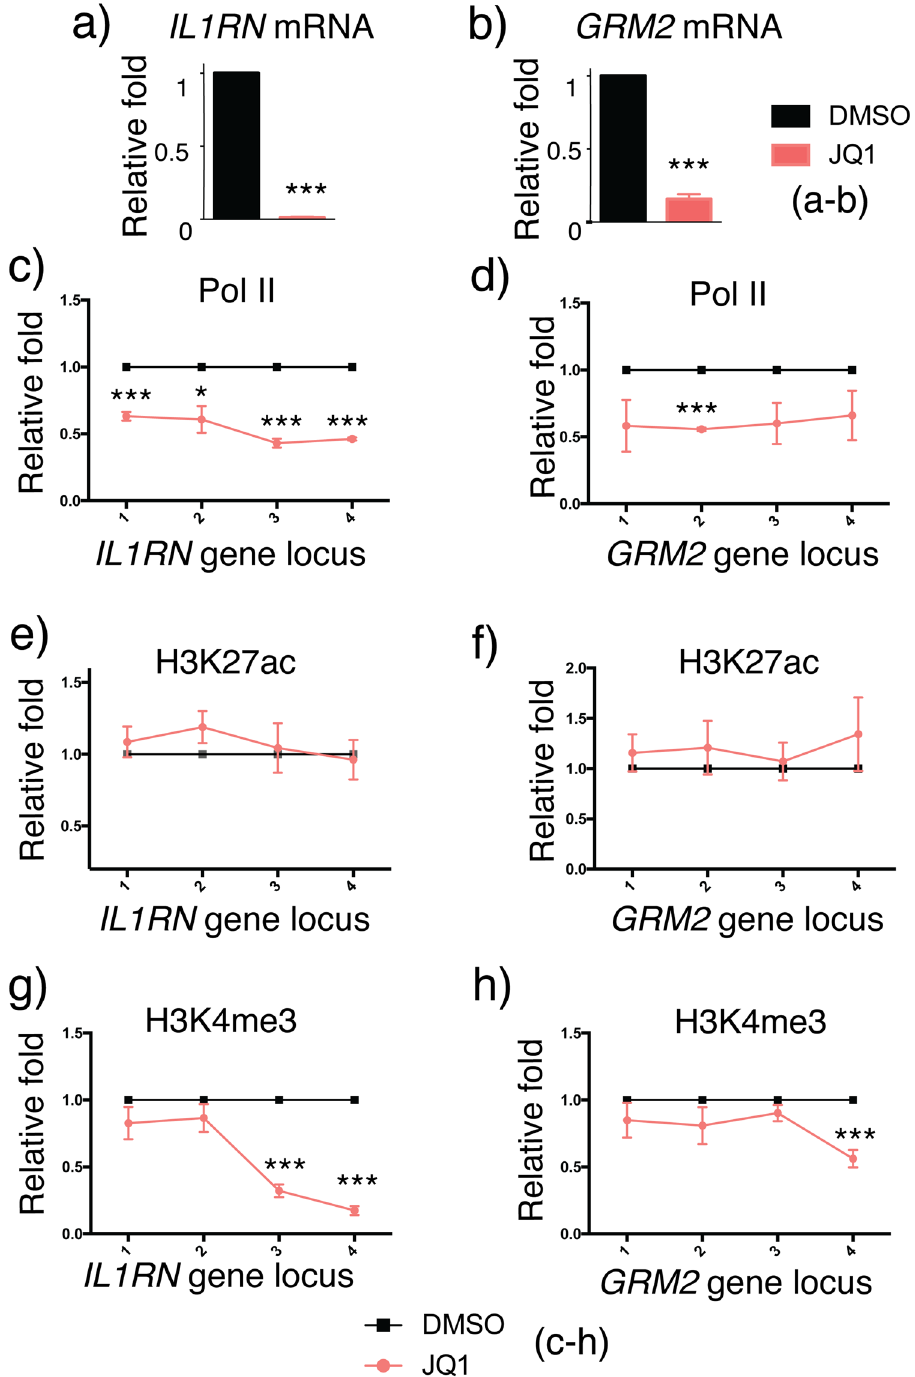
Figure 4. Effects of JQ1 treatment in dCas9-p300-induced H3K27ac writing and gene activation. The mRNA level changes of ( a ) IL1RN and ( b ) GRM2 under dCas9-p300 targeting with or without JQ1 treatment. The enrichment fold changes of RNA polymerase II at ( c ) IL1RN and ( d ) GRM2 loci upon JQ1 treatment. The enrichment fold changes of H3K27ac at ( e ) IL1RN and ( f ) GRM2 loci upon JQ1 treatment. The enrichment fold changes of H3K4me3 at ( g ) IL1RN and ( h ) GRM2 loci upon JQ1 treatment. Fold changes of Pol II, H3K27ac and H3K4me3 enrichment as well as the mRNA level changes were calculated by normalizing results to those from samples of DMSO treatment. Error bars represent ± s.e.m. from biological replicates (n = 3 for a–d ; n = 4 for e , f ; n = 5 for g , h ). The p value less than 0.05 was marked as *, less than 0.01 as ** and less than 0.001 as